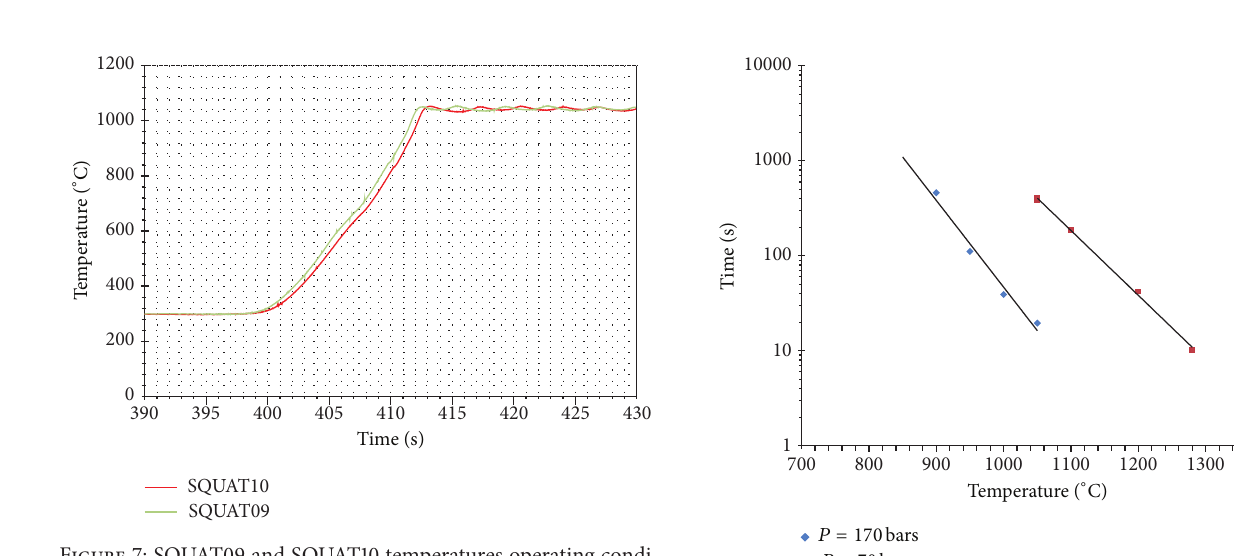
Figure 7: SQUAT09 and SQUAT10 temperatures operating condi- tions.